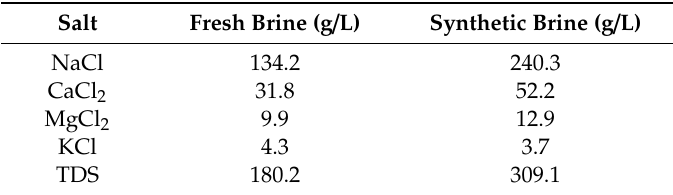
Table 1. Brines total dissolved solids content.